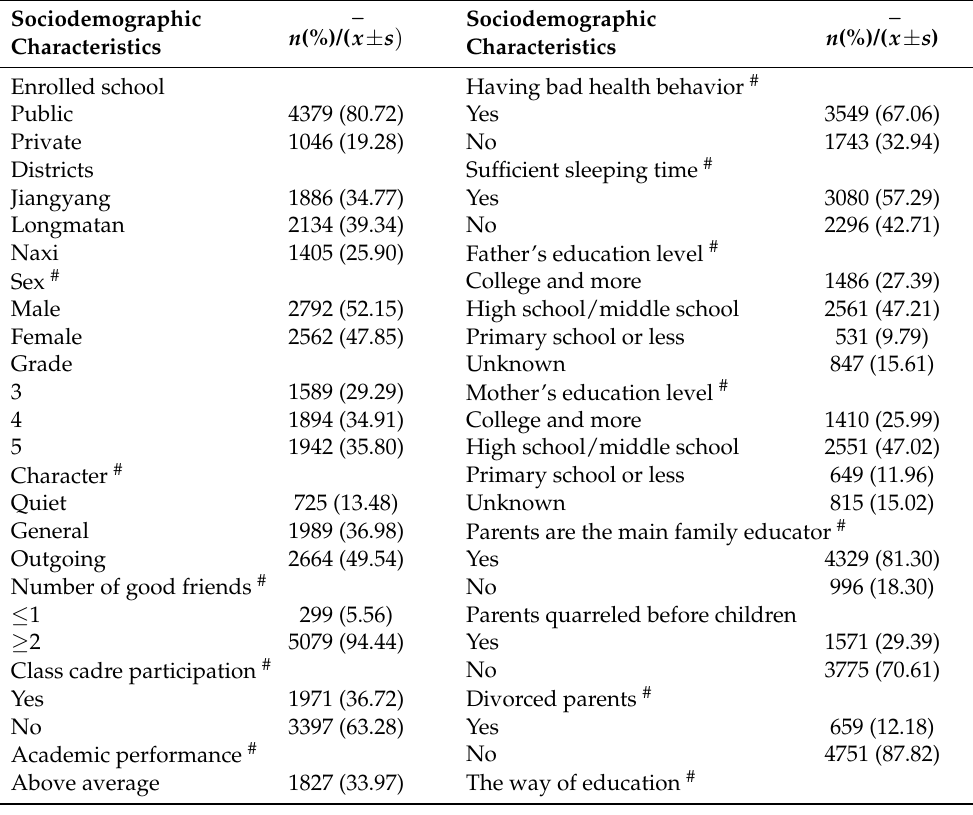
Table 1. Sociodemographic characteristics of the participants in Luzhou City, China [ n (%)/ ( x ± s )].